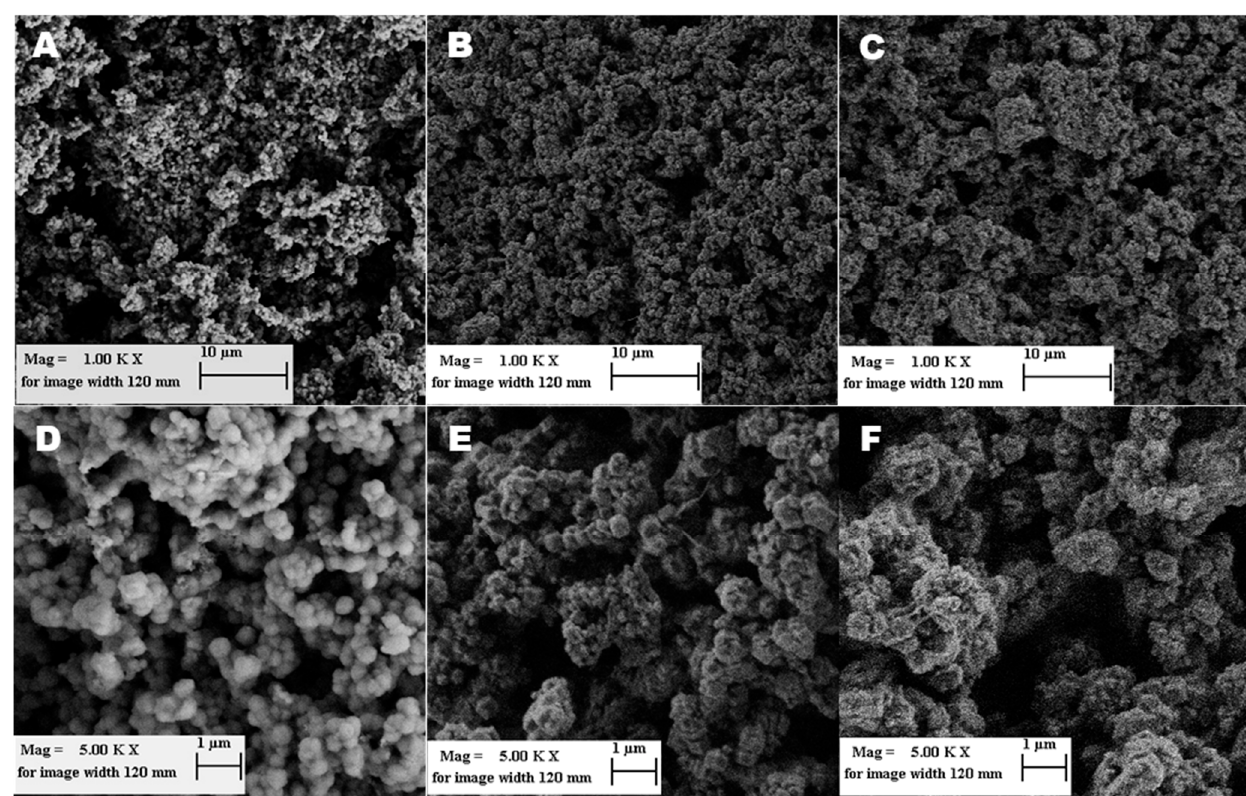
Figure 5. SEM images showing Basolite ® Z1200 ( A , D ) and ZIF-8/PVDF composite layers with 10% ( B , E ) and 40% PVDF ( C , F ).